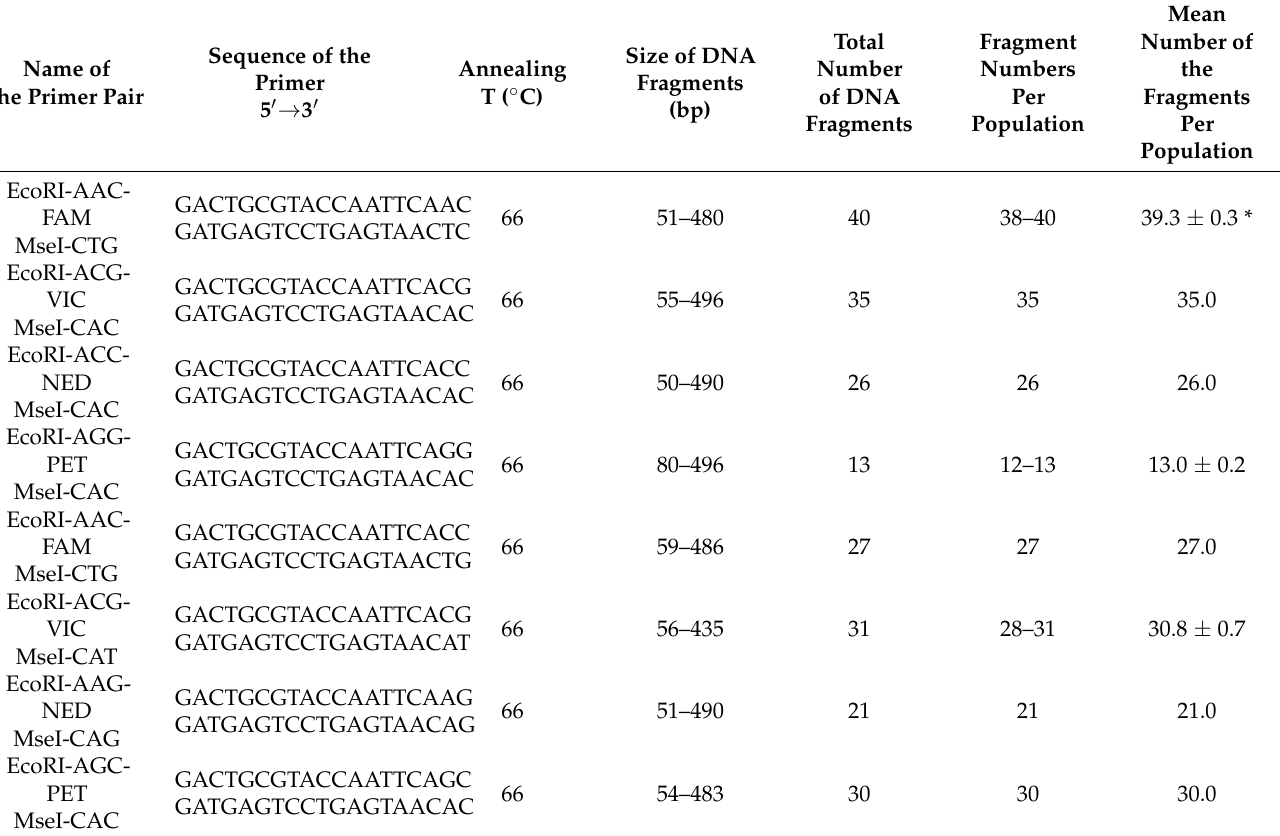
Table 1. Characteristics of AFLP primers, size and number of DNA fragments generated at AFLP loci of populations of small balsam ( Impatiens parviflora